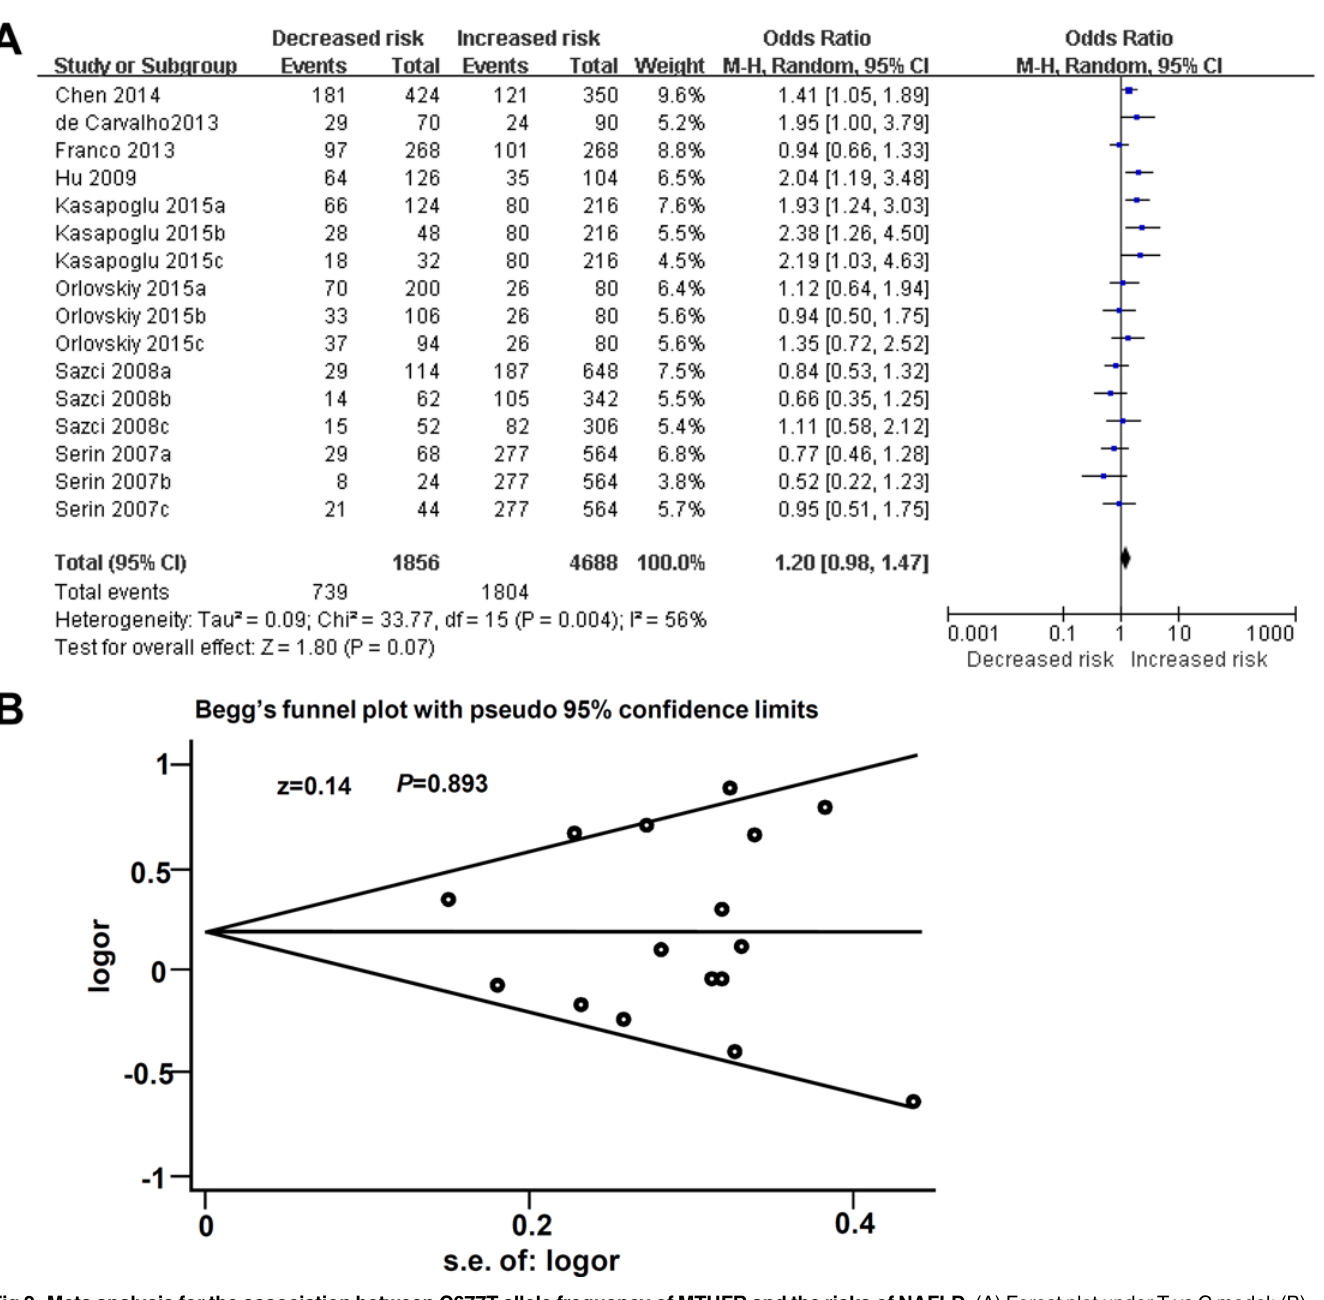
PLOS ONE | DOI:10.1371/journal.pone.0154337 April 29,